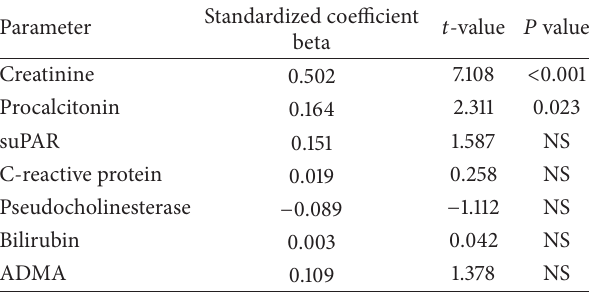
Table 3: Multivariate regression analysis of parameters determining SDMA levels.